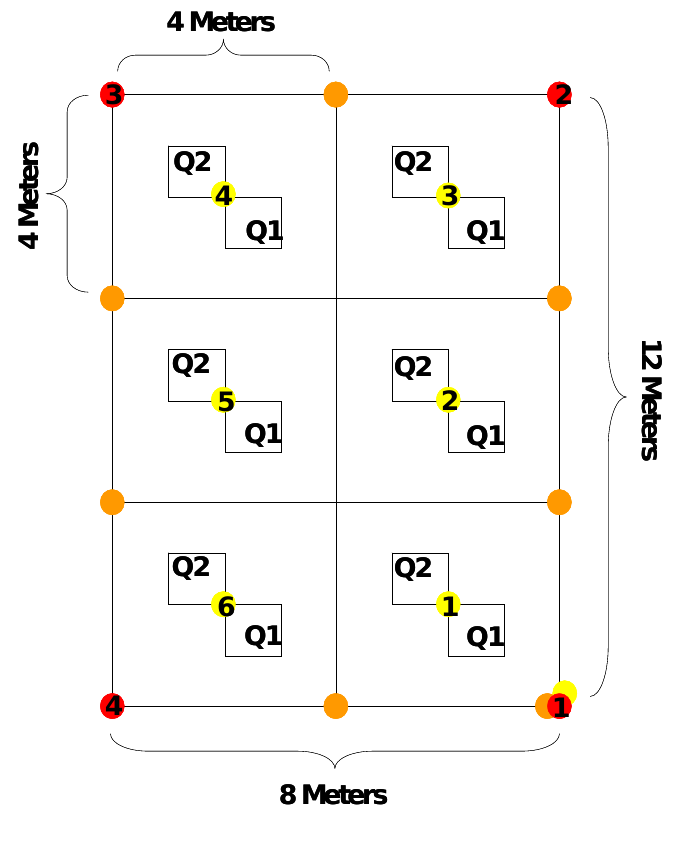
Figure 1. Layout and dimensions of treatment plots (4 m × 4 m areas) and vegetation sampling quadrats within treatments (Q1 and